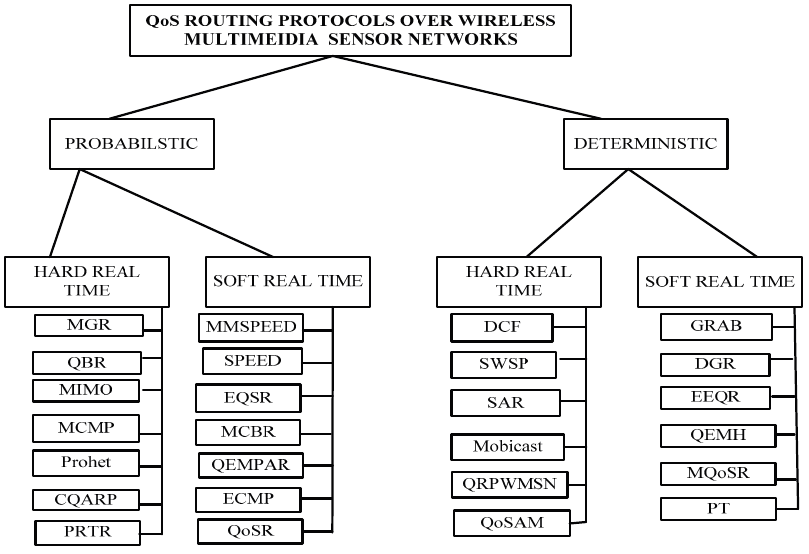
Figure 1. Classification of real-time quality of service (QoS) routing